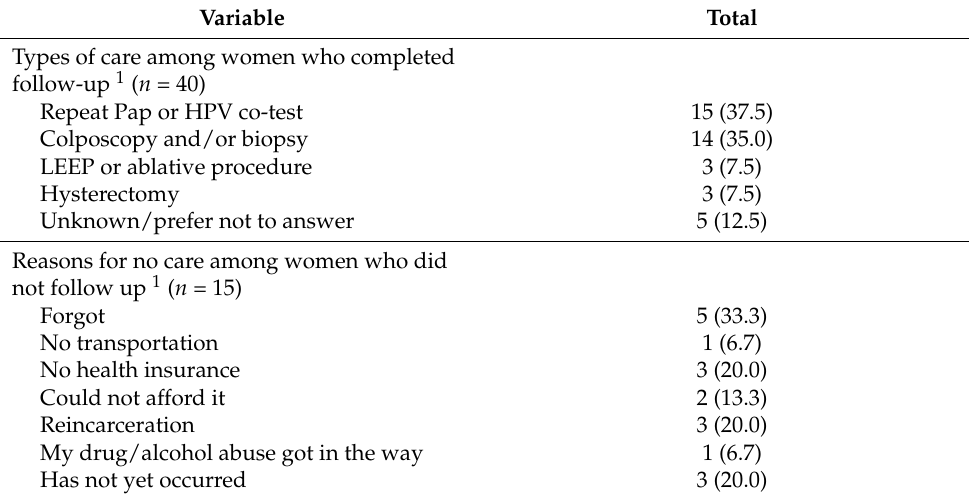
Table 2. Abnormal Pap follow-up among criminal-legal involved